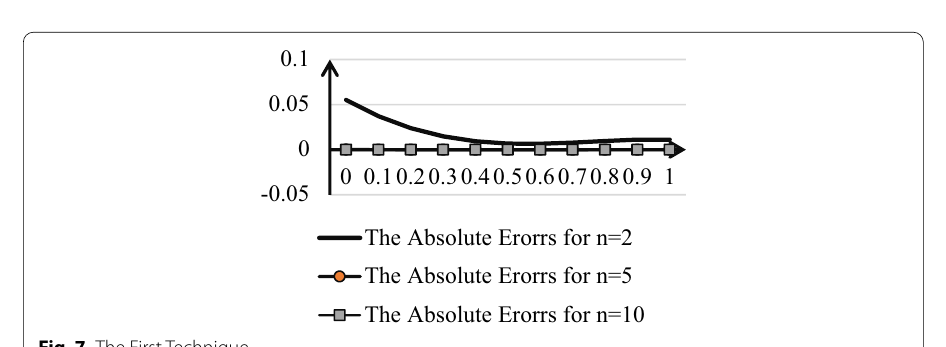
Fig. 7 The First